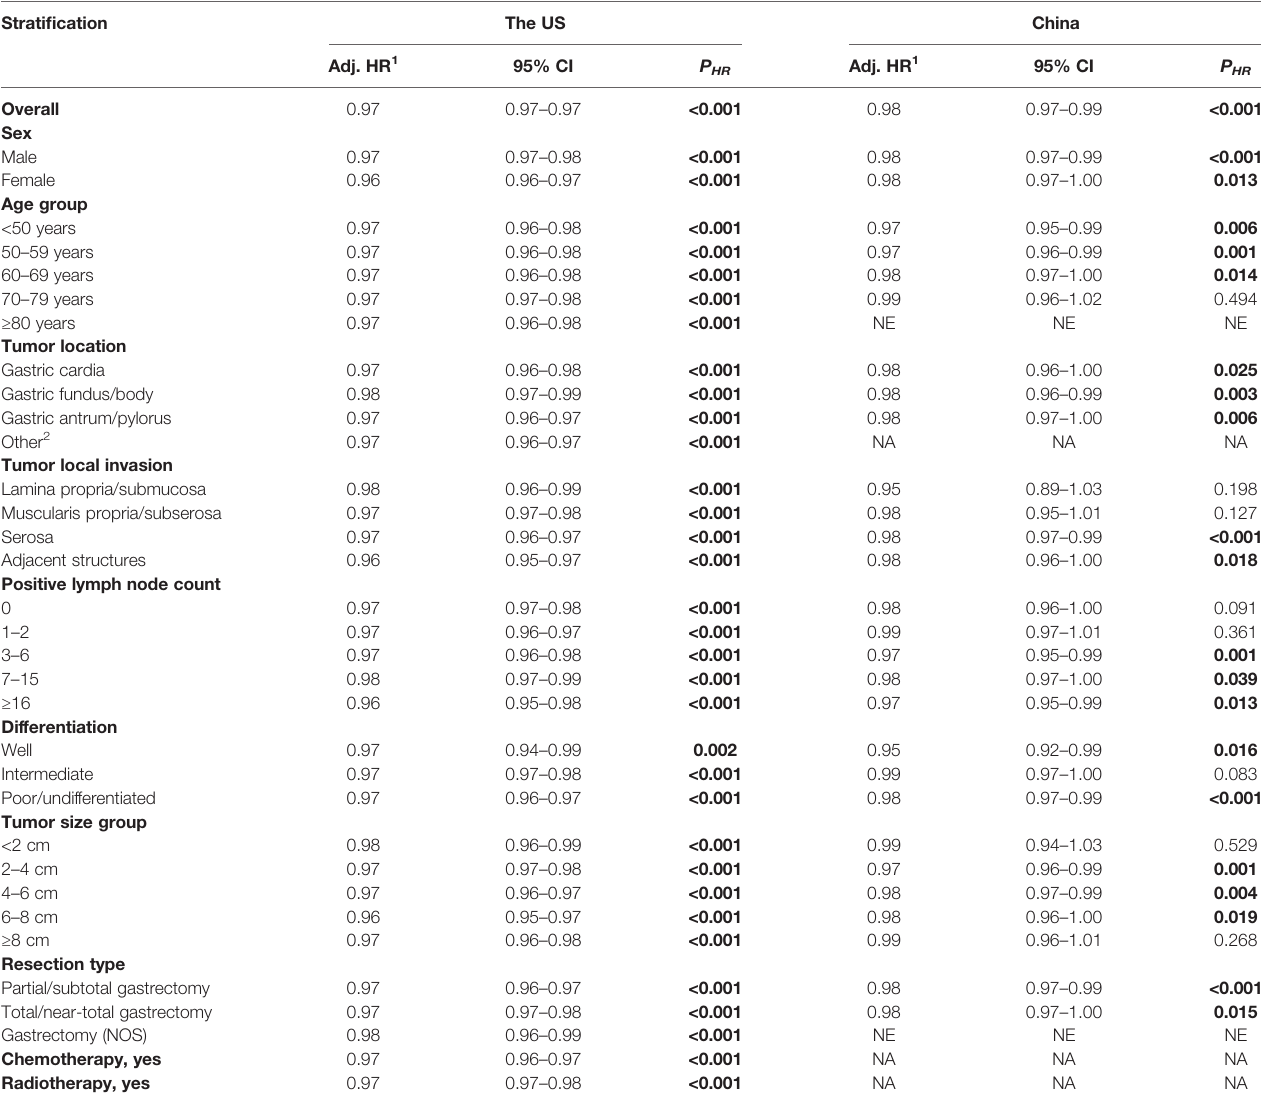
TABLE 3 | Association of examined lymph node count (entered as continuous) with overall survival in resected non-metastatic gastric adenocarcinoma patients with ≥ 1 examined lymph node using multivariable -adjusted Cox proportional hazards regression, overall and in subgroups by patient, tumor, and treatment factors 1 . Strati fi cation The